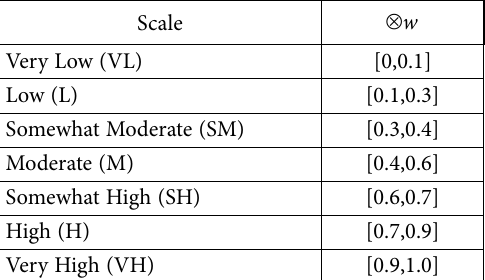
Table 3. The scale of attribute level of